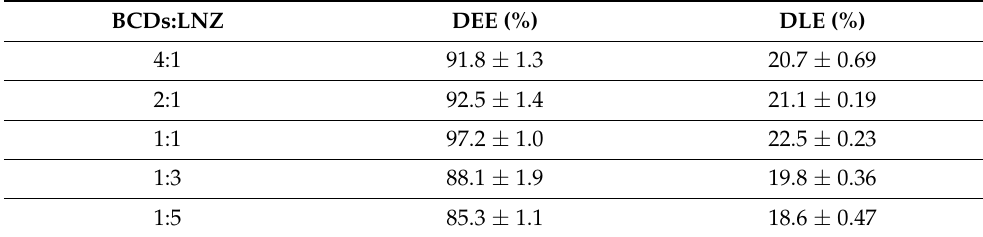
Table 1. Data of drug loading and encapsulation efficiency of LNZ–BCDs nano-bioconjugates.